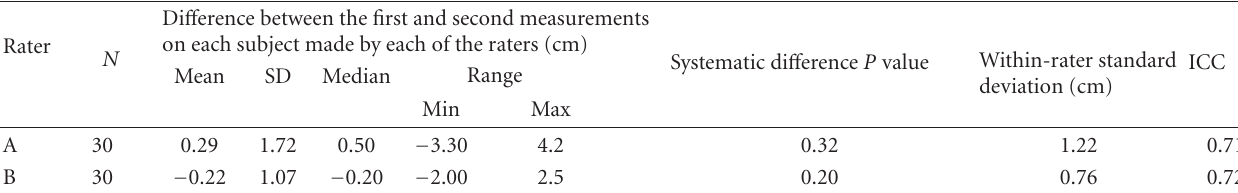
Table 2: Assessment of the intra-rater agreement for the cervical translation mobility in the sagittal plane for rater A and B. The mean values for the di ff erences between the two measurements made by A and the two measurements made by B are presented together with its SD, medians, and ranges, as well as the P values for the systematic di ff erence, the within-rater standard deviation, and the intraclass correlation coe ffi cient